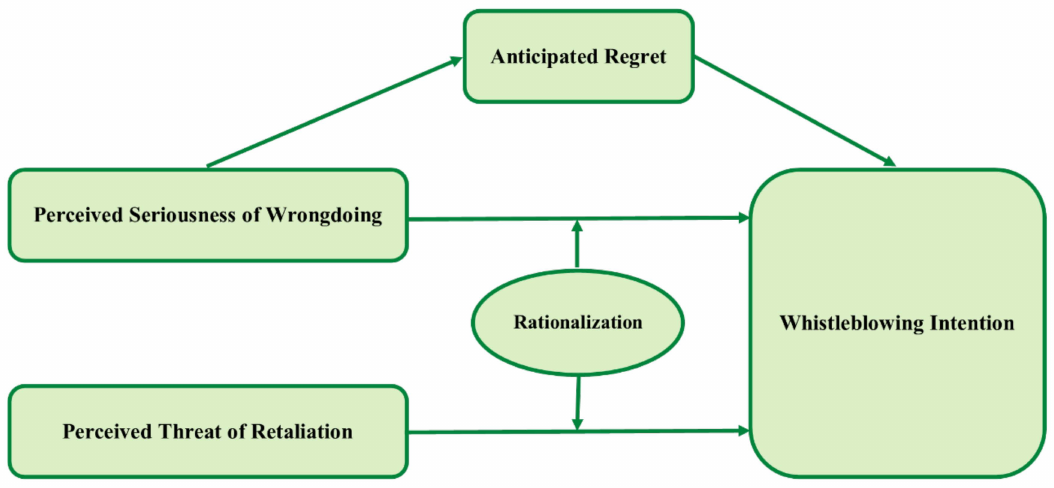
Figure 1. Theoretical